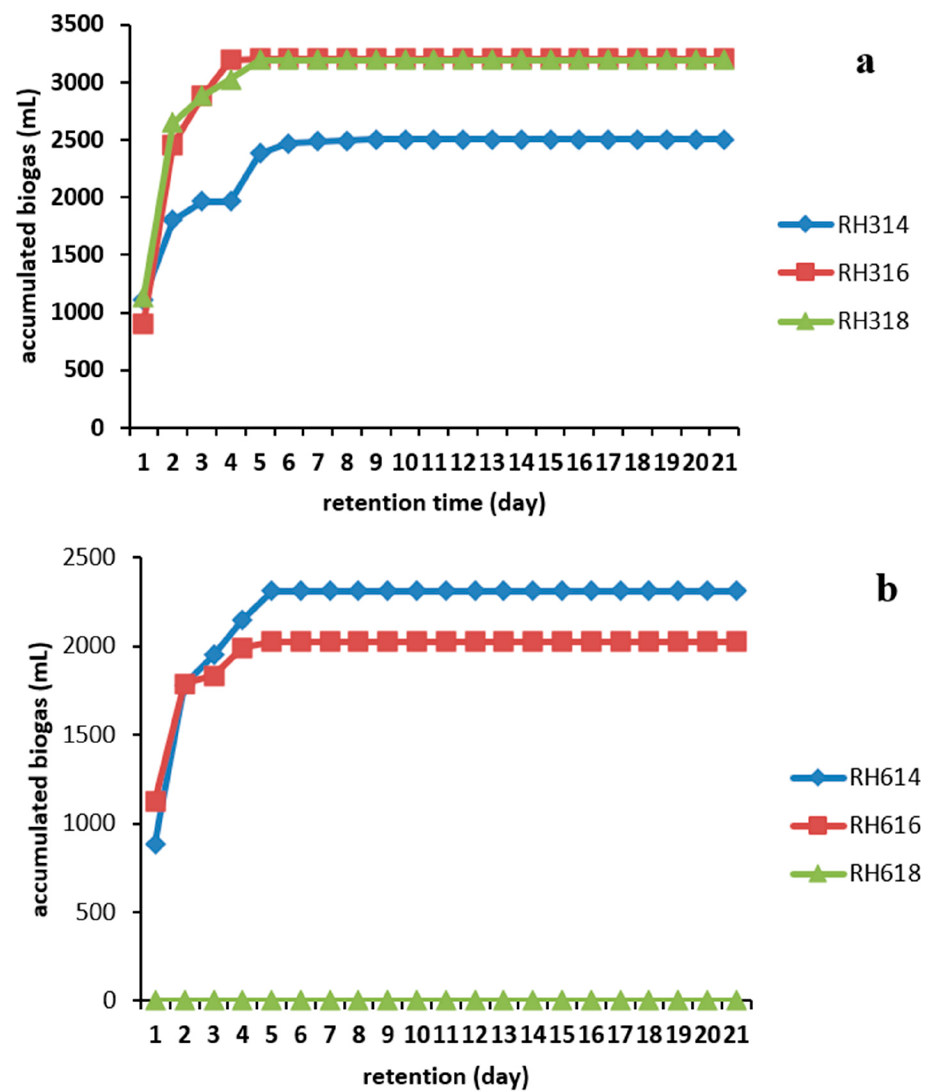
Figure 4. Accumulated biogas production from RH for two particle sizes: ( a ) 300 and ( b ) 600 μ